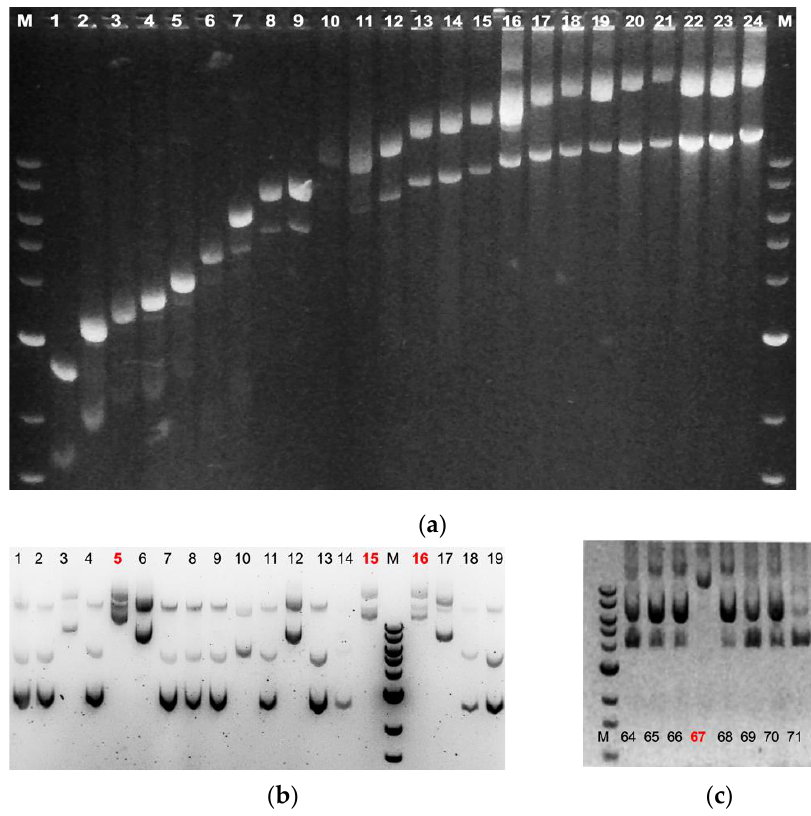
Figure 3. Ability to discriminate supercoiled, undigested plasmids by size using Lyse&Load. The bright RNA bands in these gels are cropped out of the final image or were allowed to run off the gel. Interestingly, the bacterial genomic DNA typically floated out of the well soon after loading. Positive supercoiled DNA runs faster than linearized; relaxed circular DNA runs slower; the supercoiled forms observed depend on the culture conditions. ( a ) A total of 24 different plasmids were selected based on size (see Table 1), cultures were inoculated from frozen bacterial stocks harboring plasmids, and undigested plasmids were loaded onto the gel in order of increasing size on a 1.0% agarose/TAE gel. Depending on the overall lengths of the plasmid, a 5% difference in size can easily be detected. ( b ) Successful screening for a ~12kb plasmid using Lyse&Load. Colonies from a transformation plate were inoculated in 500 µ L culture media and shaken at 37 ◦ C for 4–6 h. The culture tubes were centrifuged, and concentrated cells were subjected to Lyse&Load as described. Additional media was added to culture tubes #3, 5, 6, 10, 12,15, 16, and 17 for overnight culture and molecular analysis the following day. Plasmids #5, #15, and #16 were correct. The cloning strategy used here gave rise to multiple classes of plasmids with incorrect (smaller) inserts than expected. ( c ) Lyse&Load screening for a 13,278 bp plasmid. The cloning strategy did produce the correct product, but at a low frequency. The correct version was identified through brute force screening of colonies produced using several different transformation strategies. One correct plasmid (#67) out of >100 colonies screened was found. (M = molecular weight marker). The MW marker sizes are: 12, 10, 8, 6, 4, 3,